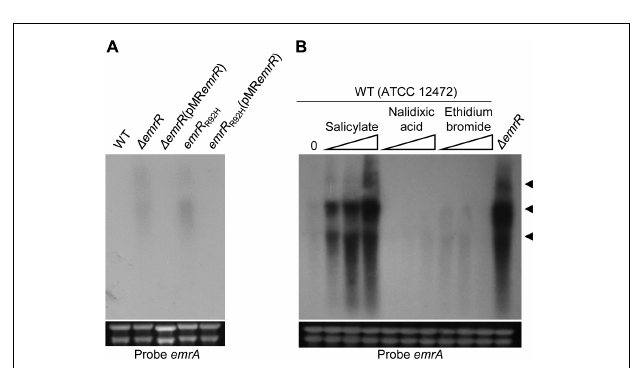
FIGURE 6 | Nalidixic acid resistance in emrR mutants correlated to overexpression of the efflux pump EmrCAB. (A) Northern blot analysis using total RNA from the indicated strains grown in LB medium revealed that null or point mutation in emrR causes overexpression of emrCAB . (B) Salicylate caused derepression of emrCAB . Northern blot assay was performed using total RNA extracted from the wild-type strain ATCC 12472 before (0) or after exposure for 10 min to salicylate (0.1, 1.0, and 10 mM), nalidixic acid, and ethidium bromide (0.1, 0.2, and 0.5 mM), or RNA extracted from (cid:49) emrR grown in LB medium. Levels of rRNA were used as a loading control (bottom panels). RNA samples were hybridized with a probe for emrA . Head arrows indicate putative isoform transcripts of the emrCAB operon. Distinct band intensity between (A,B) reflects differences in time